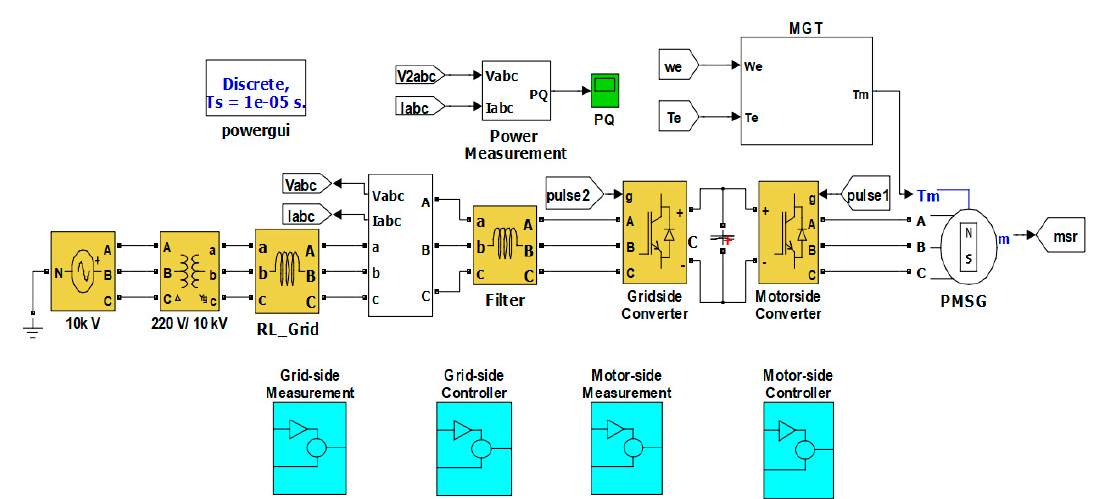
Figure 9. Simulation model of the grid-connected CHP.